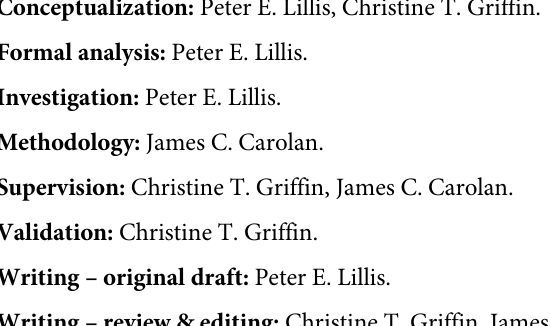
fold transformed abundances 2